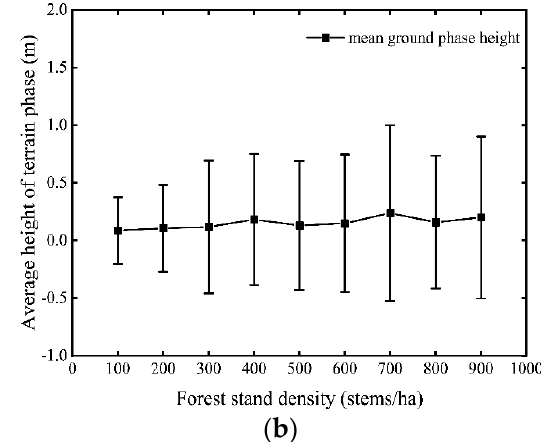
Figure 12. Error bar plot of ground phase center relative heights. ( a ) DEM difference method ( b ) RVoG ground phase method.